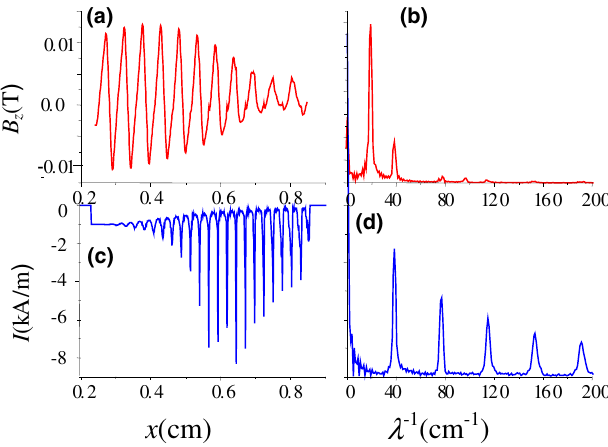
FIG. 6. (Color) Space dependence of magnetic field and (cid:2) x (cid:4) near grating, (b) corresponding FFT, (c) I (cid:2) x (cid:4) , current: (a) B z (d) corresponding FFT (Dartmouth).